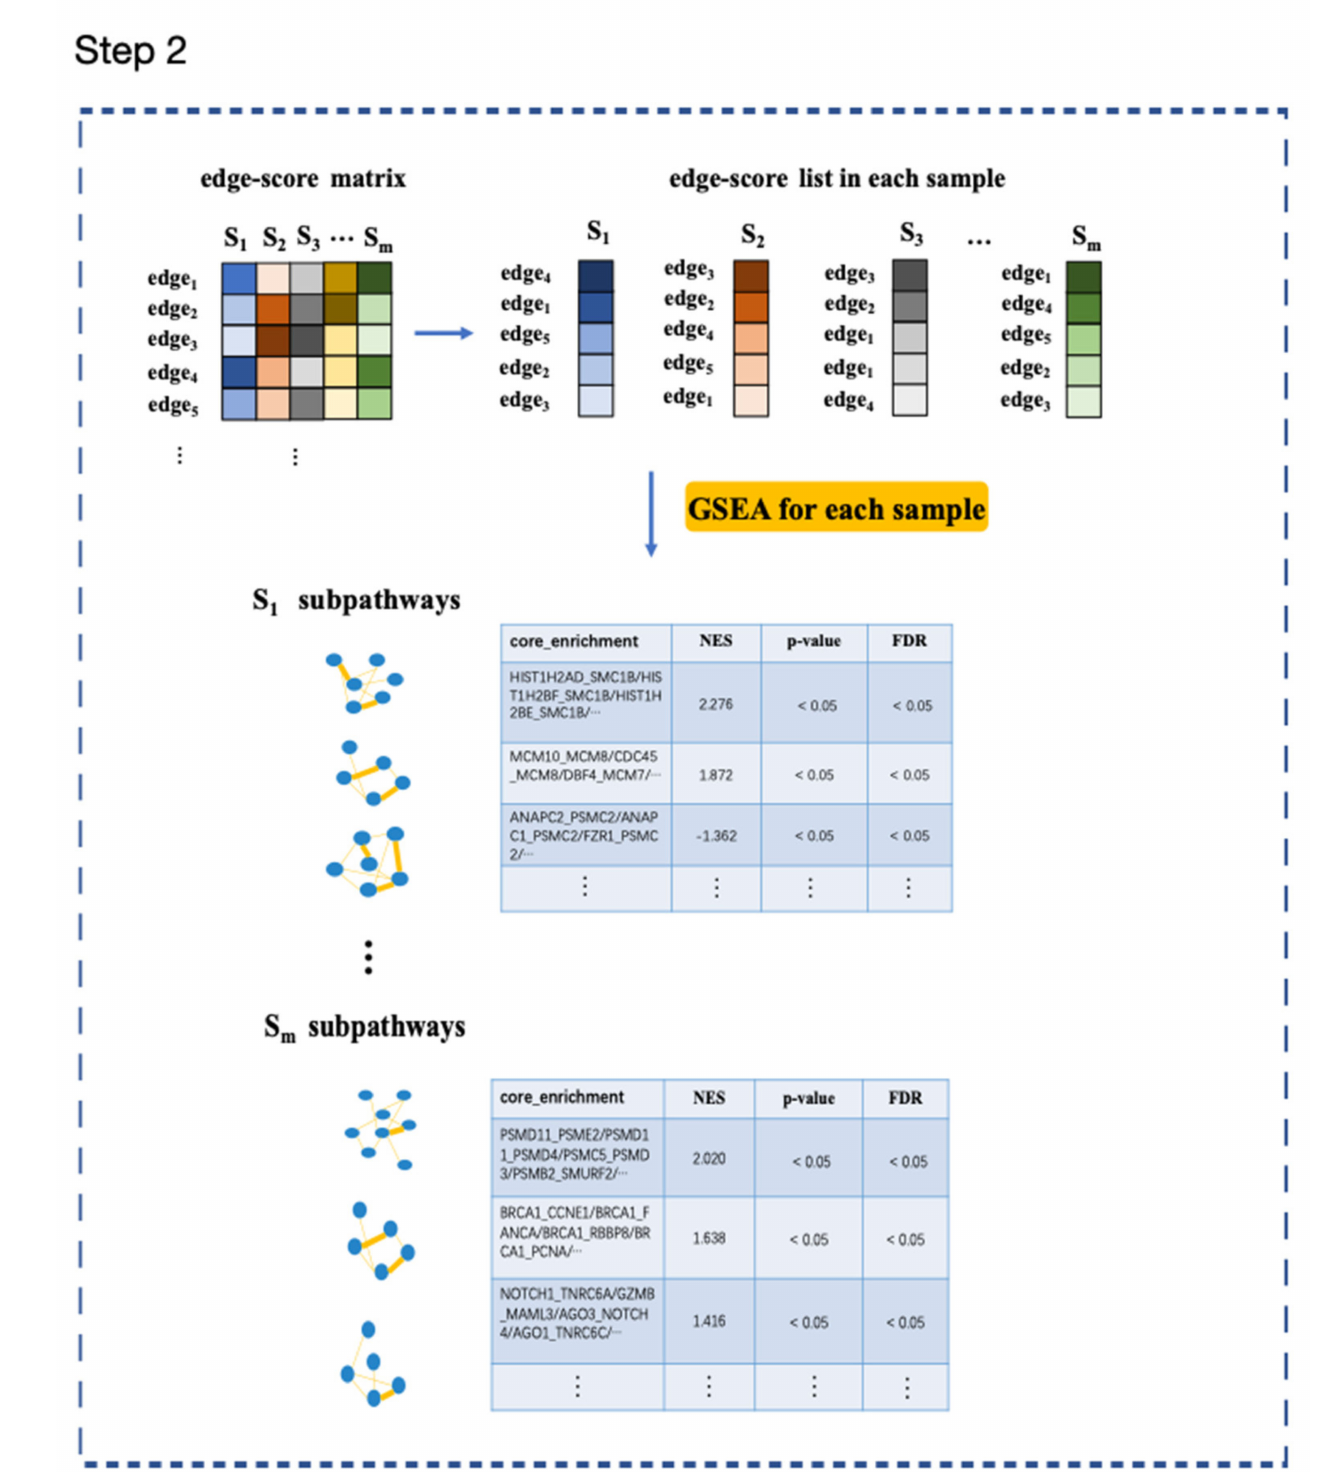
Figure 1. Schematic overview of subpathway